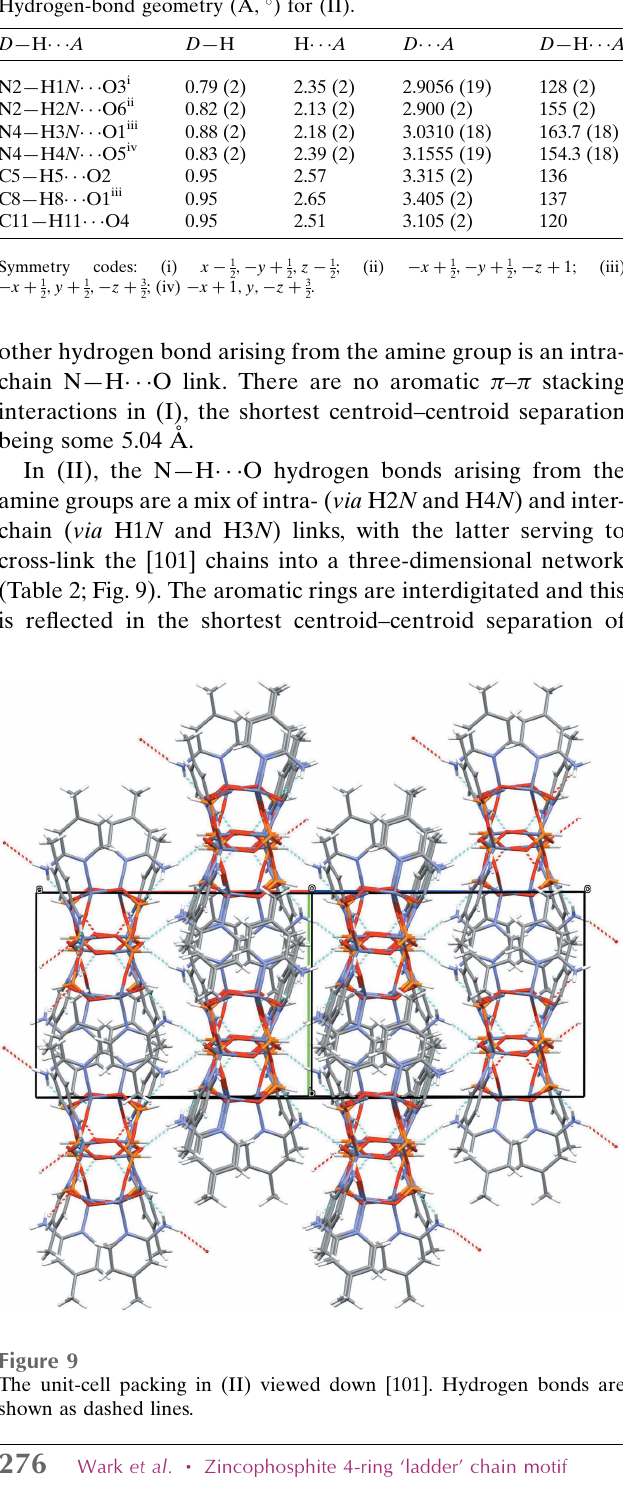
Acta Cryst. (2023). E 79 , 272–279